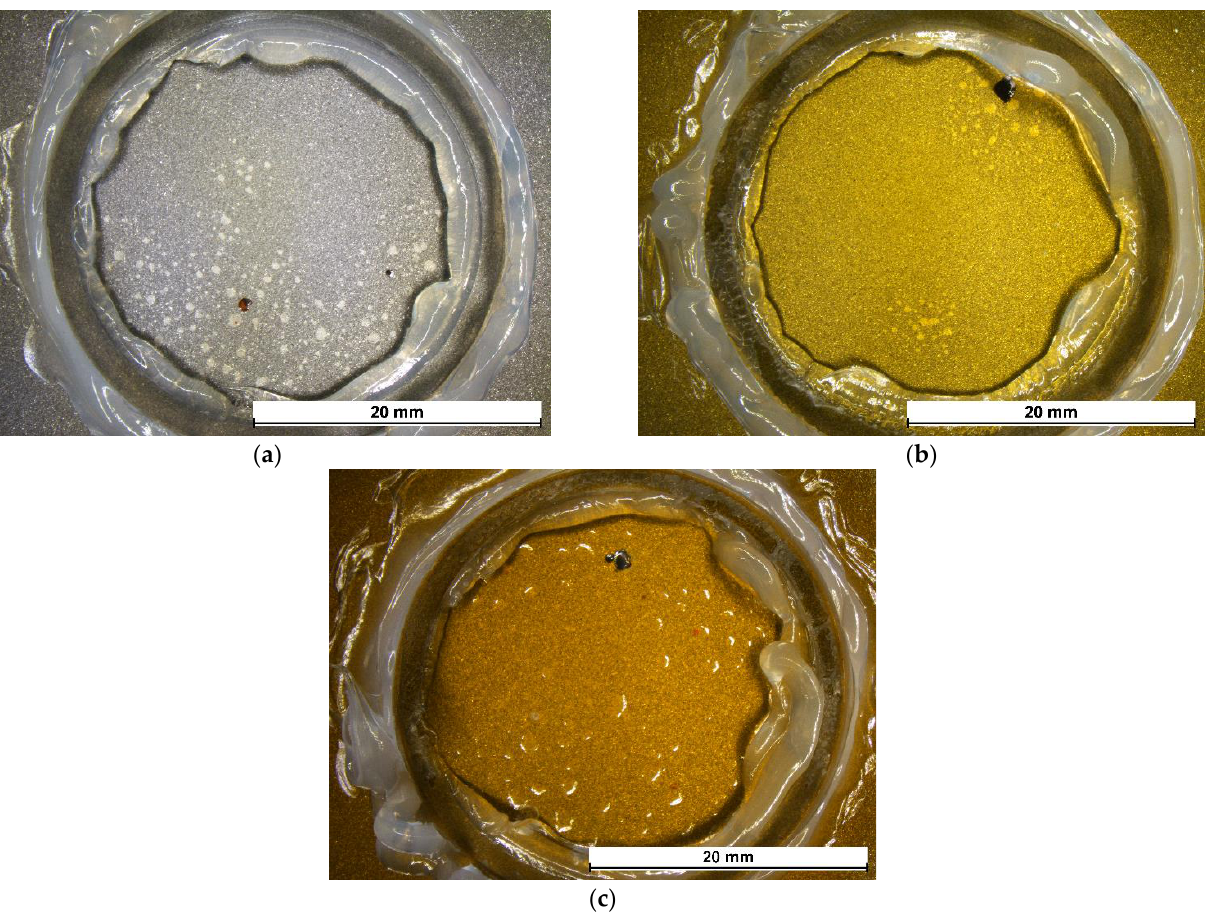
Figure 11. Surface of sample A ( a ), A1 ( b ) and A2 ( c ), after 500 h of immersion in test solution.